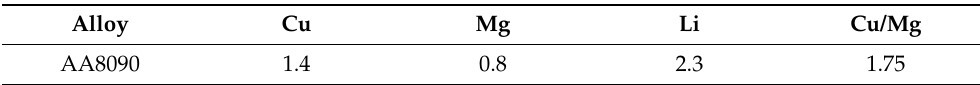
Table 7. Influence of Cu on corrosion in the Base